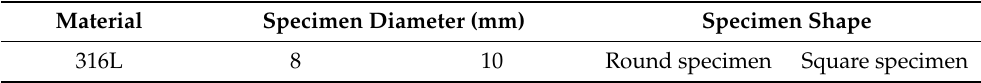
Table 8. FE model parameters of 316L stainless steel with different specimen sizes.